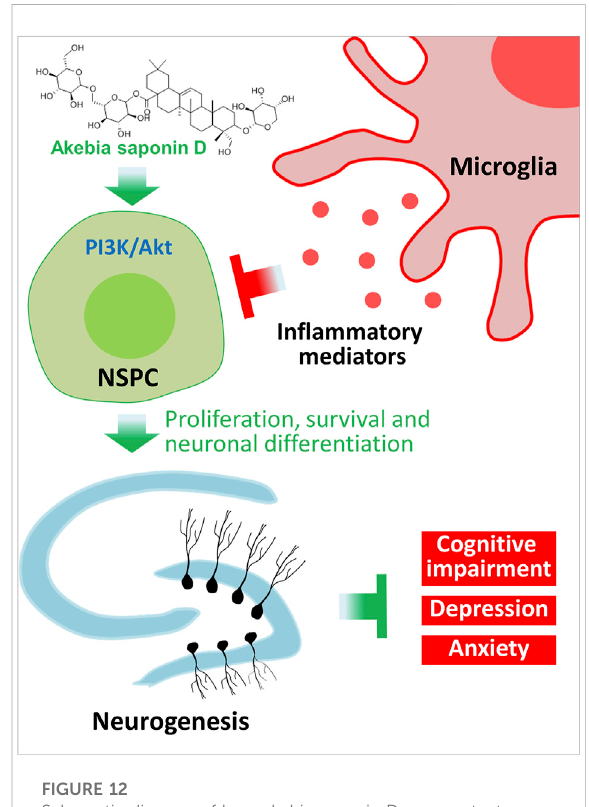
FIGURE 12 Schematic diagram of how akebia saponin D may protect hippocampal neurogenesis. Akebia saponin D activates the PI3K- Akt pathway to protect NSPCs from the microglia-mediated in fl ammatory niche, promoting their proliferation, survival and neuronal differentiation, as well as ameliorating depressive- and anxiety-like behaviors and cognitive